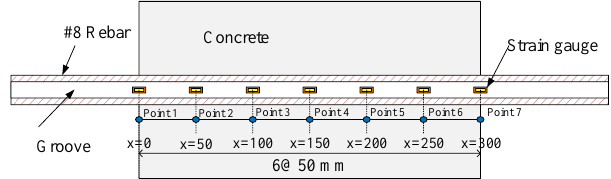
Figure 4. Calculation points for the steel strain.